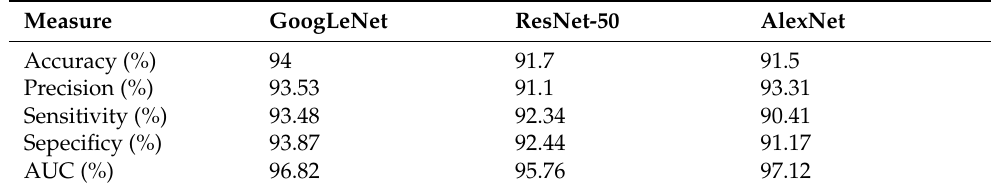
Table 4. Evaluative results of diagnosed CT images of hemorrhage dataset using GoogLeNet, ResNet- 50 and AlexNet.